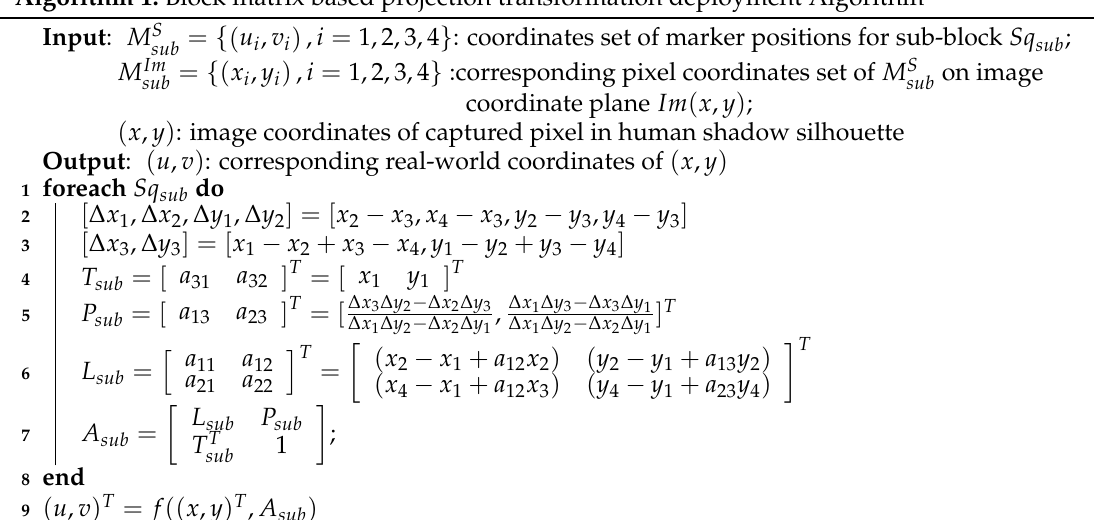
Algorithm 1: Block matrix based projection transformation deployment